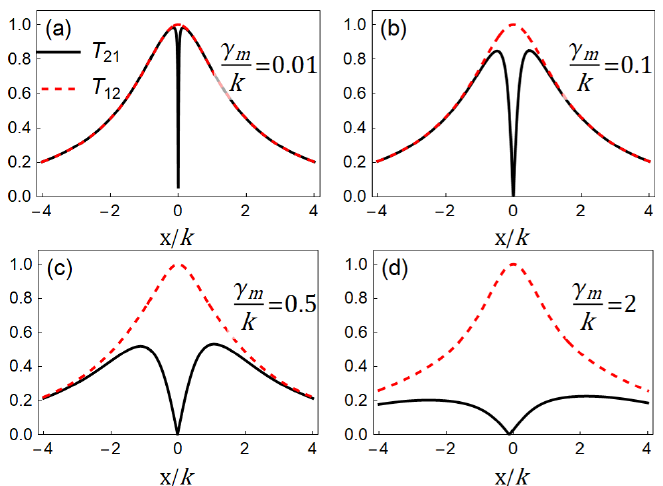
(cid:0) ∆ (cid:48) = (cid:1) and the system is in red detuning (cid:4666)Δ (cid:4593) ＝ 2(cid:2033) (cid:3040) (cid:4667) , transmission amplitudes (cid:1846) (cid:2870)(cid:2869) and the system is in red detuning 2 ω m , transmission amplitudes T 21 (cid:2870) 2 (cid:4666)(cid:1876) ＝ (cid:2012) (cid:3398) 2(cid:2033) (cid:3040) (cid:4667) ( x = δ − 2 ω m ) k (cid:3038) = 0.01, ( b ) γ m = 0.1, ( c ) γ m = 0.5, and ( d ) γ m = 2. The other (cid:3404) 0.01 , ( b ) (cid:3082) (cid:3288) (cid:3404) 0.1 , ( c ) (cid:3082) (cid:3288) (cid:3404) 0.5 , and ( d ) (cid:3082) (cid:3288) (cid:3404) 2 . The other param ‐ : ( a ) (cid:3082) (cid:3288) : ( a ) γ m k k k k k (cid:3038) (cid:3038) (cid:3038) (cid:3038) (cid:3038) √ k 1 k 2 , G 1 2